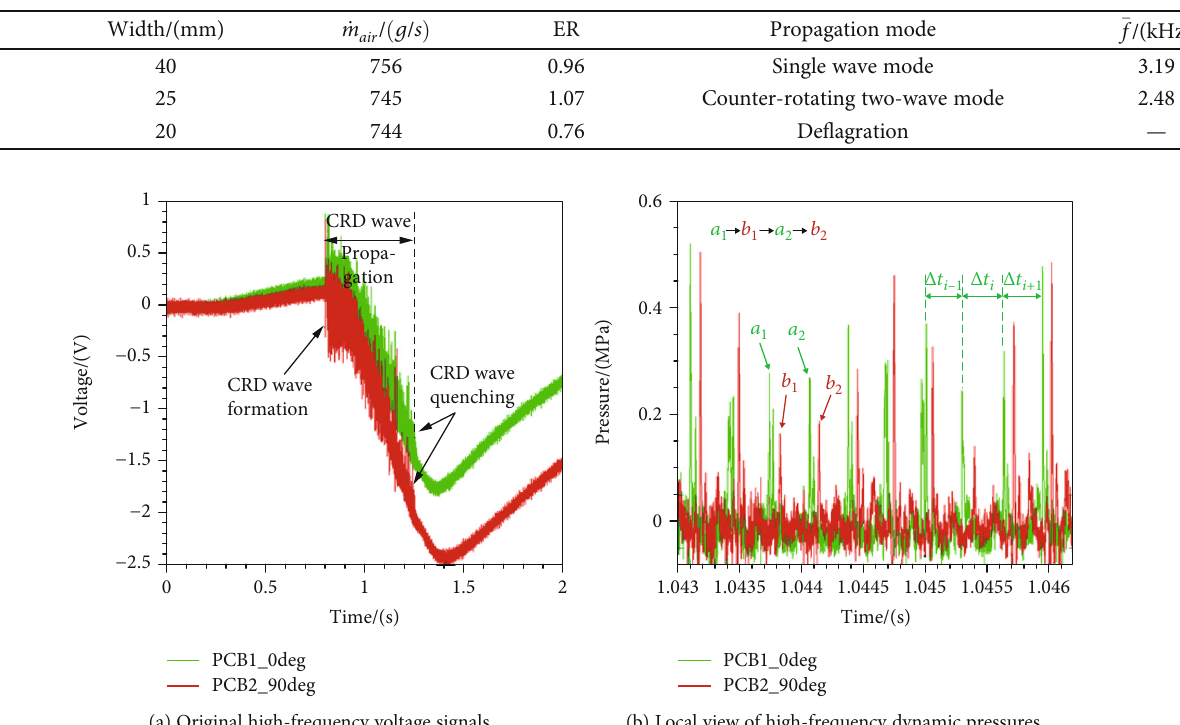
Figure 4: High-frequency pressure results of Test